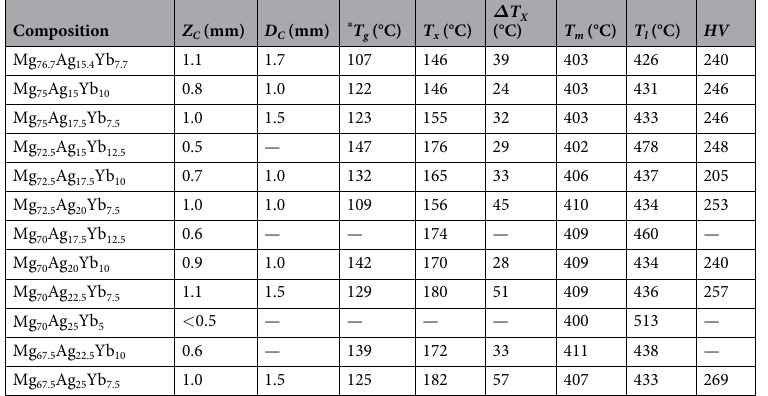
Table 2. BMG-forming compositions in the Mg-rich region of the Mg–Ag–Yb ternary system, and their associated critical casting sizes, thermophysical properties, and Vickers hardness. * T g values quoted here are the onset temperatures of the glass transition.